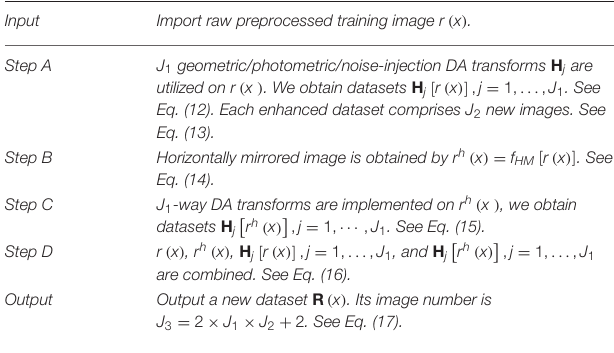
Fourth, the raw image r ( x ) , the horizontally mirrored image r h ( x ) , J 1 -way datasets of raw image H j [ r ( x ) ], and J 1 -way datasets of horizontally mirrored image H j final generated dataset from r ( x ) is defined as R ( x ) :